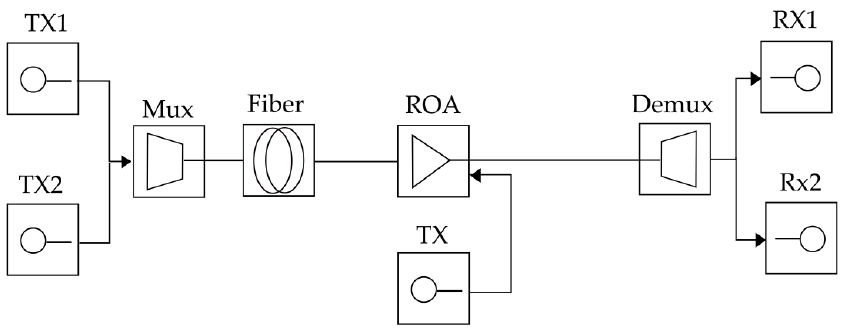
Figure 5. ROA amplifier scheme in optical system.